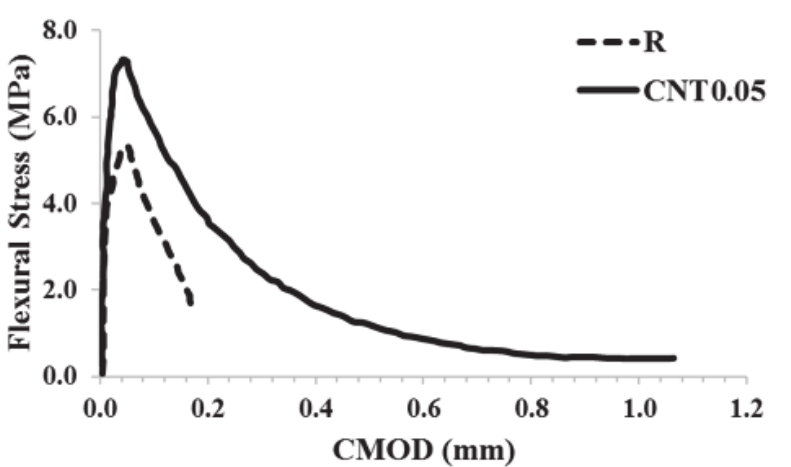
Figure 3: Typical stress vs. CMOD curves of concrete specimen with and without MWCNTs.